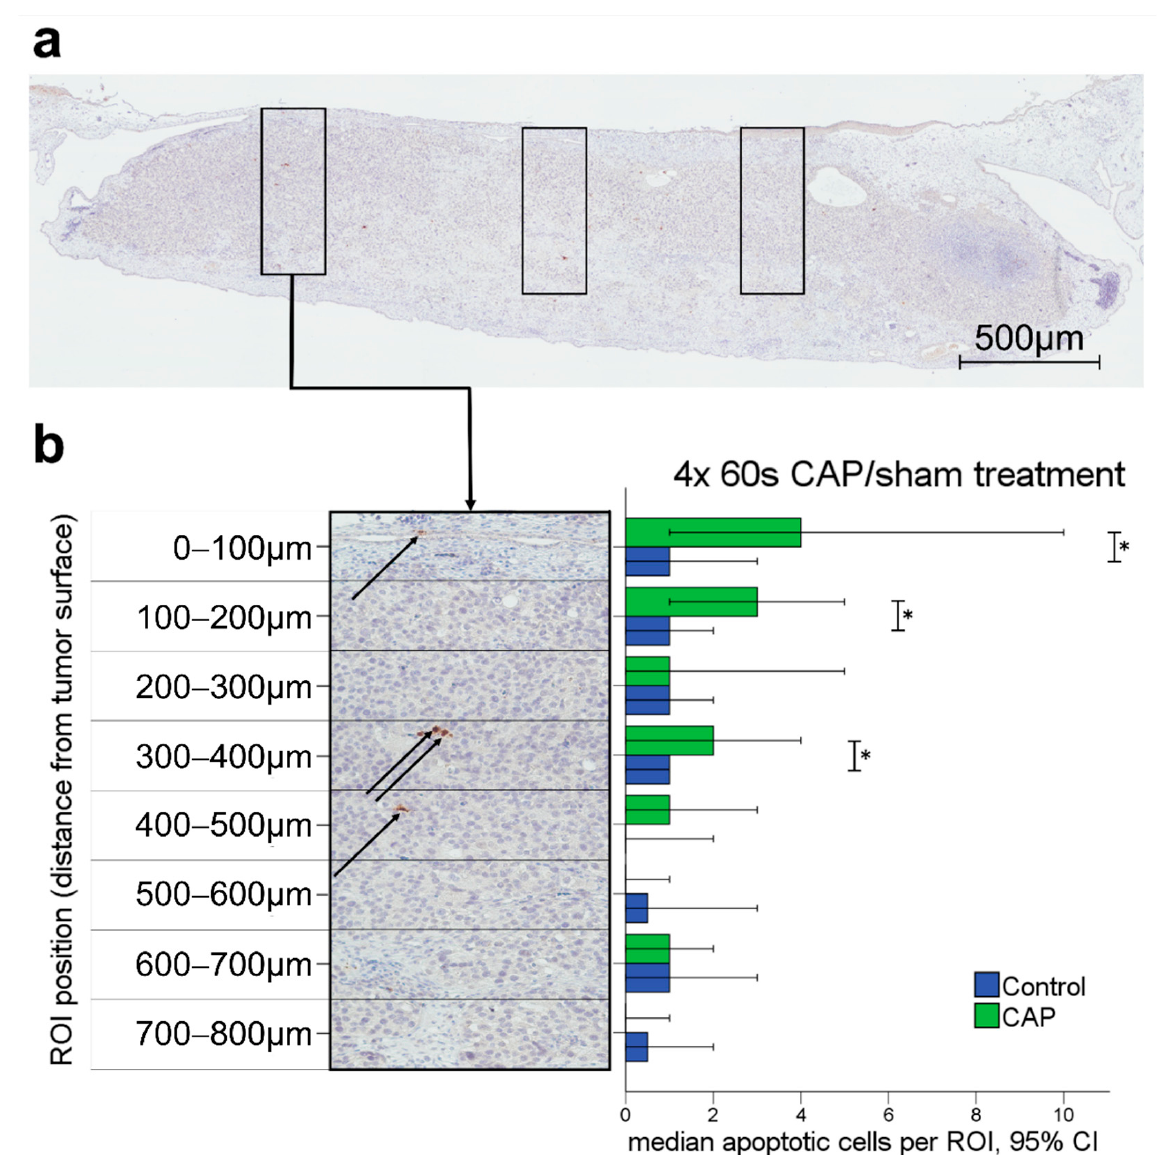
Figure 3. Apoptotic cell rates were analyzed in cleaved caspase-3 stained tumor slides. ( a ) Solid tumor in the CAM with three columns of ROI, scale bar length 500 µ m; ( b ) Column of eight ROI with 400 × 100 µ m each. Arrows indicate apoptotic cells. Median apoptotic cells by ROI position (distance from tumor surface). Significantly higher rates of apoptotic cells were observed in regions distanced less than 200 µ m and between 300–400 µ m from the tumor surface. * p < 0.05